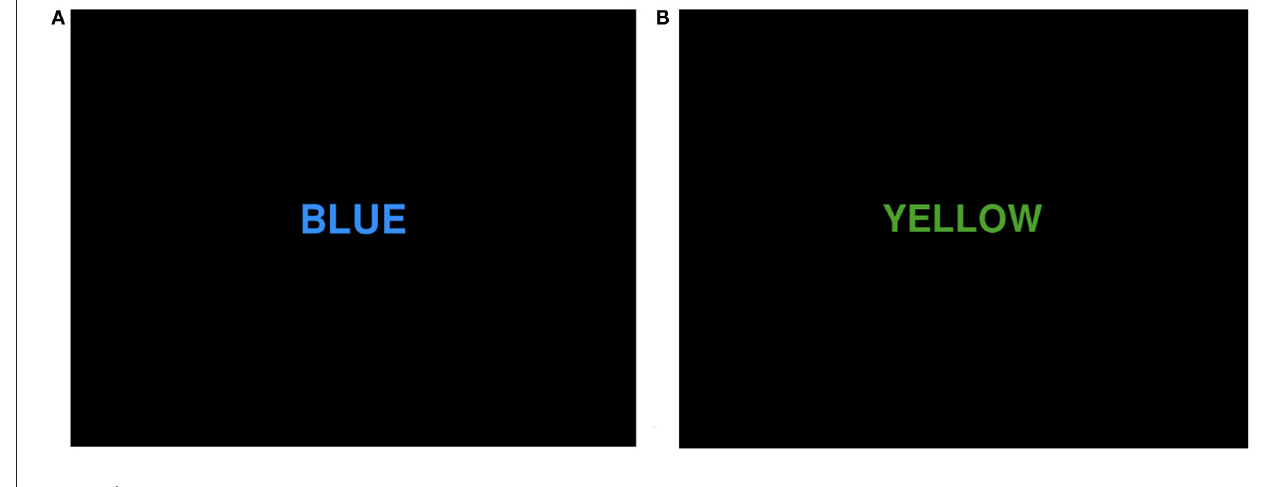
FIGURE 1 | Two different types of Stroop tasks: (A) congruent task; (B) incongruent task.